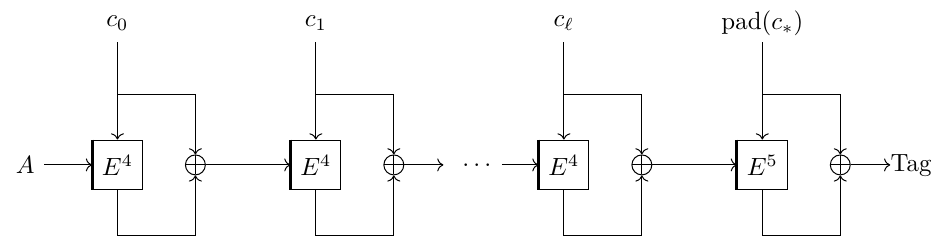
Figure 8: Cascade construction, processing of the ciphertext and computation of the tag. A thick line represents the input of the key.